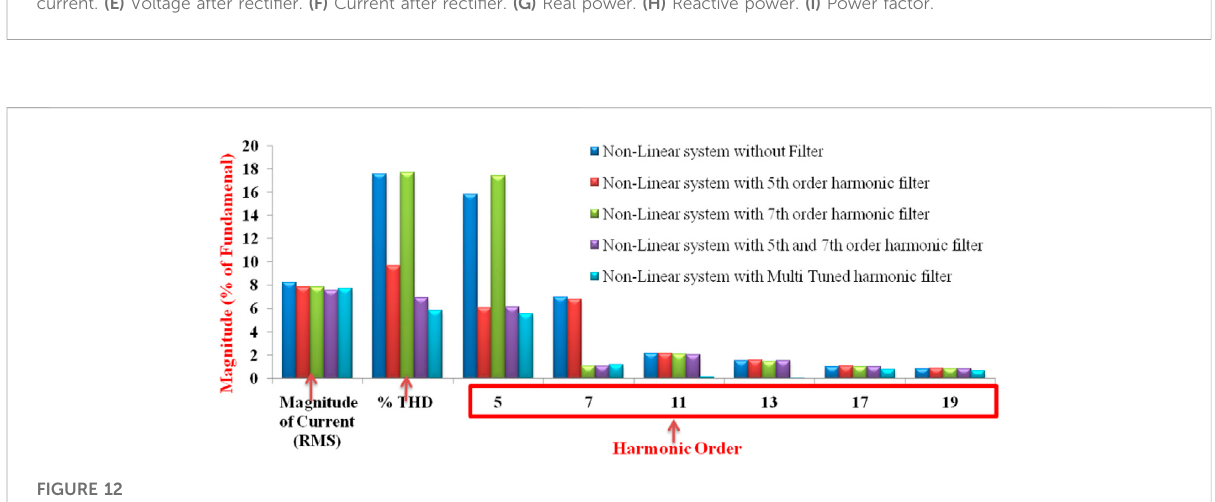
FIGURE 12 % THD for different passive fi lters and FFT